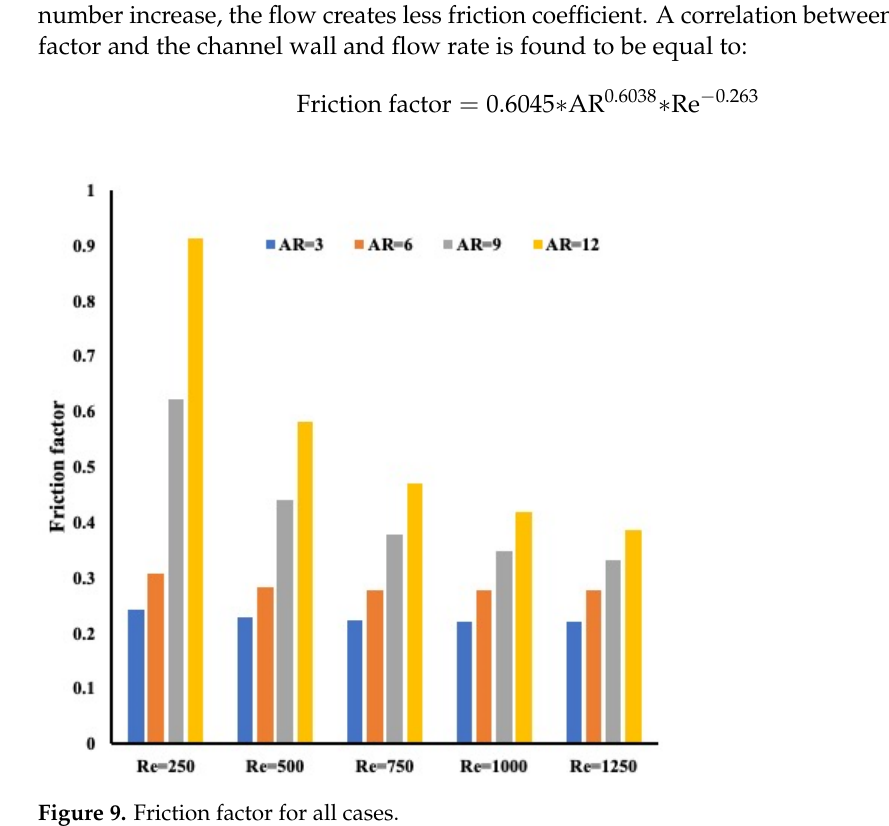
Figure 8. Average Nusselt number for all cases.